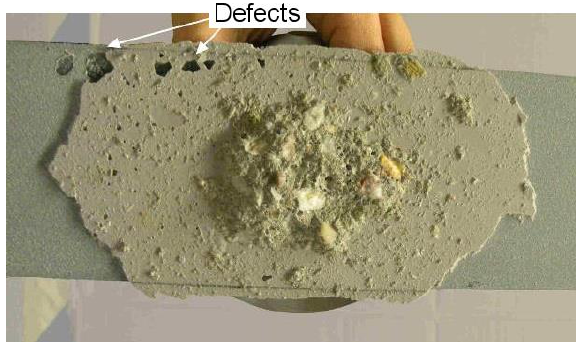
Figure 10. Example of a fracture aspect after complete debonding of the composite plate.